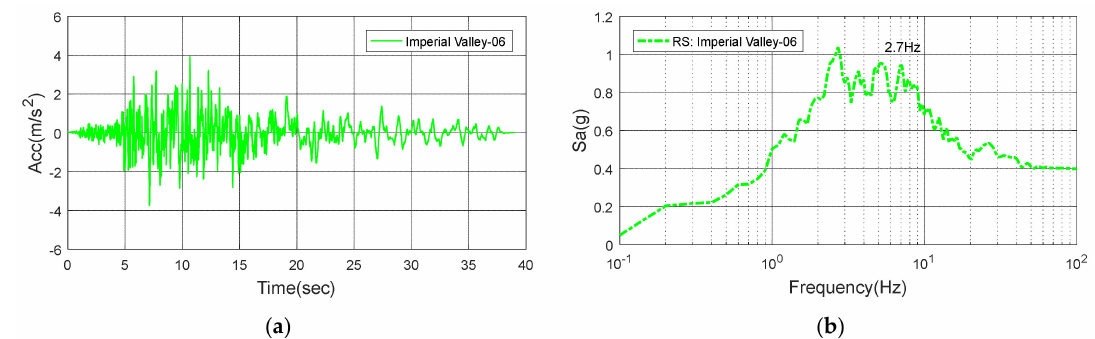
Figure 18. Friuli: ( a ) Time history; ( b ) Response spectrum.